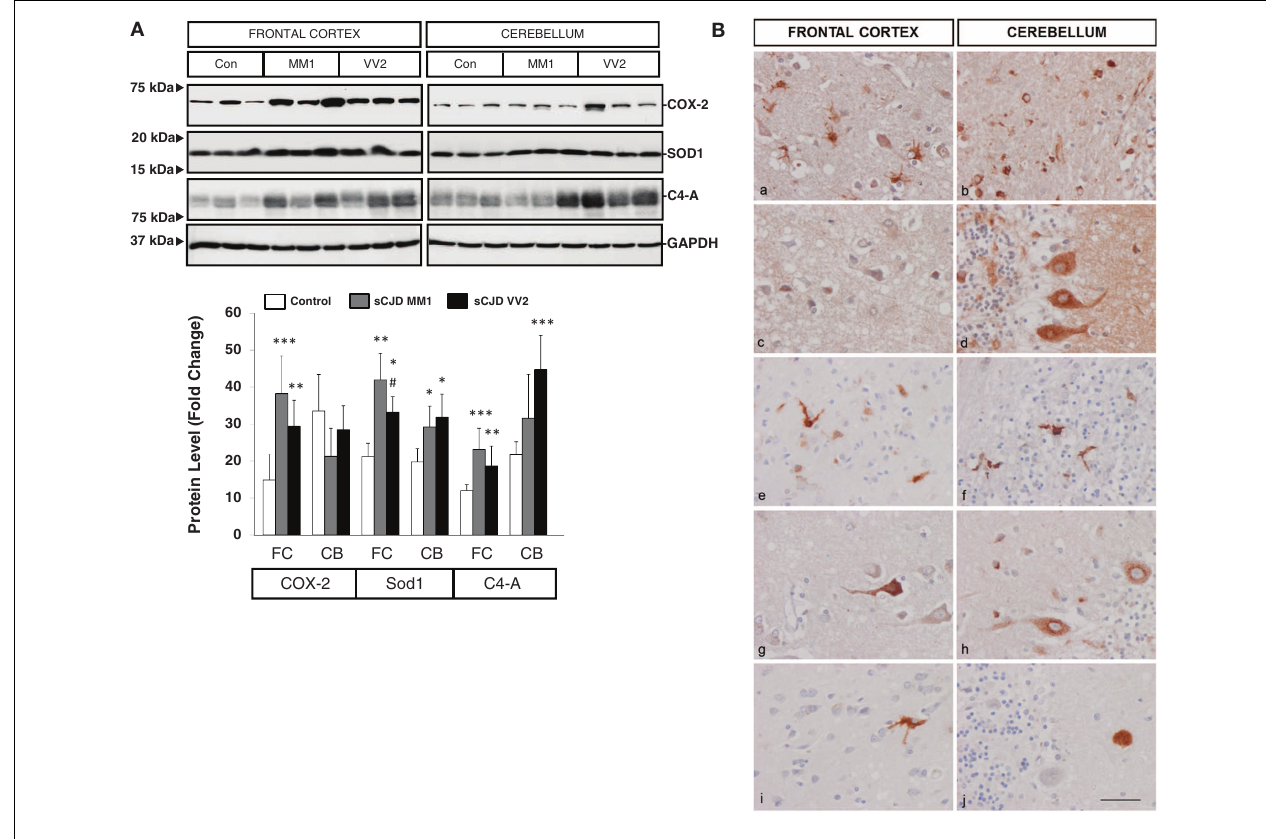
when compared to controls. * p > 0.05, ** p > 0.005, *** p > 0.001 control versus sCJD; # p > 0.05, ## p > 0.005 sCJD MM1 versusVV2. AU: arbitrary units. (B) Immunohistochemistry of cytokines and immune mediators in sCJD MM1 frontal cortex (a, c, e, g, i) and cerebellum (b, d, f, h, j); a, b: IL6; c, d: IL10; e, f: ILR10; g, h:TNF-alpha; i, j: M-CSF. Note that IL6, IL10RA, andTNF- α are expressed in glial cells, mainly microglia, whereas IL10, M-CSF, andTNF α are expressed in neurons. Paraffin sections, slightly counterstained with hematoxylin. Bar = 10 µ